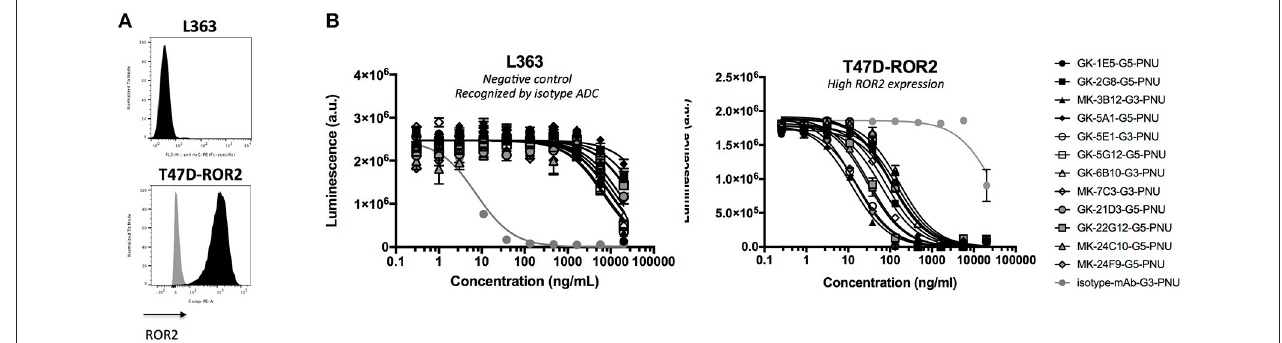
FIGURE 7 | Validation of ADCs. (A) hROR2 surface expression in cell lines used in this study as determined by FACS using the hROR2-specific antibody XBR2-401 (37) detected using a PE-labeled anti-human Fc γ . Black histograms, ROR2 staining; gray histograms, control staining with only the secondary antibody. (B) Following recovery of V H and V L sequences by RT-PCR cloning from hROR2-ECD-Twin-Strep reactive Transpo-mAb cell clones and expression in HEK293T cells, purified recombinant antibodies were site-specifically conjugated to a derivative of the potent cytotoxic payload PNU-159682 by sortase-mediated antibody conjugation (SMAC-technology TM ) to the C-termini of the heavy and light chain constant domains. These ADCs were tested for their cell killing activity on hROR2 negative (L363), and hROR2-high (T47D-hROR2) cell lines. Viability of the cells is plotted in arbitrary units (a.u.) of luminescence on the y-axis as a function of the concentration of the ADCs on the x-axis as a result of a CellTiter-Glo cell-killing assay. hROR2-negative L363 cells were used as negative controls (with an isotype-control mAb in light gray that binds to a TAA on L363). G3 and G5 designate the length of a glycine linker used in the ADCs, which has previously been shown not to affect ADC potency. Datapoints represent mean of two replicates and error bars represent SD